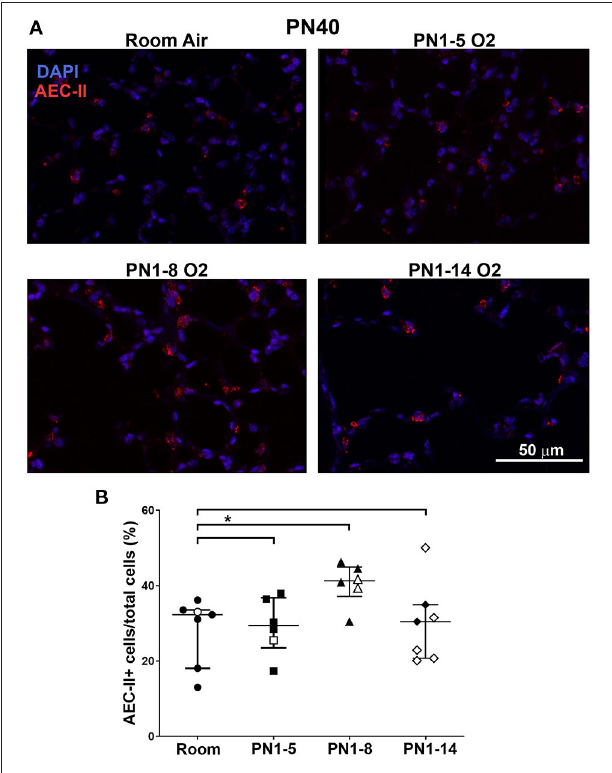
FIGURE 3 | Neonatal oxygen promotes mild AEC-II expansion in adulthood. (A) Representative immunofluorescent images of lungs from room air control mice or mice exposed to 75% oxygen for the indicated times. Staining was undertaken at PN40 with anti-Pro-SPC (red) to depict AEC-II. DAPI-stained nuclei appear blue. Scale bar = 50 µ m. Images were taken with 20x glycerol objective using a Nikon A1r inverted confocal microscope, zoom setting 2. (B) Quantitation of proportions of AEC-II + cells indicated as AEC-II + /total lung cells. Data is presented as median ± IQR. * P < 0.05 by Mann-Whitney U -test (2-tailed). n ≥ 6 mice per group, with 2–4L used in the analysis of each oxygen group. Gender is represented by closed (male) and open symbols (female). PN,